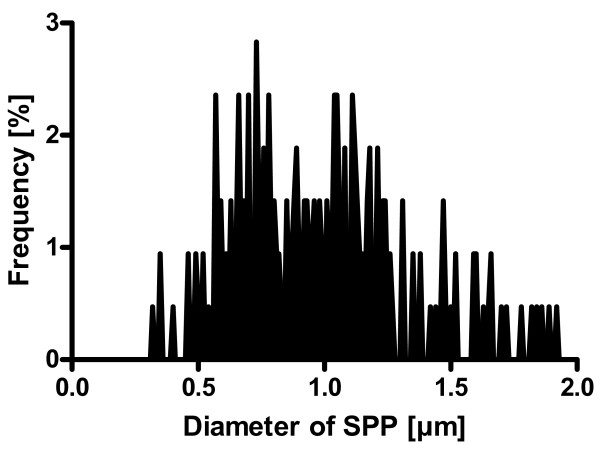
Diameter distribution of SPP. Approximately 300 SPP were analysed by scanning electron microscopy. The frequency distribution of diameters is shown.